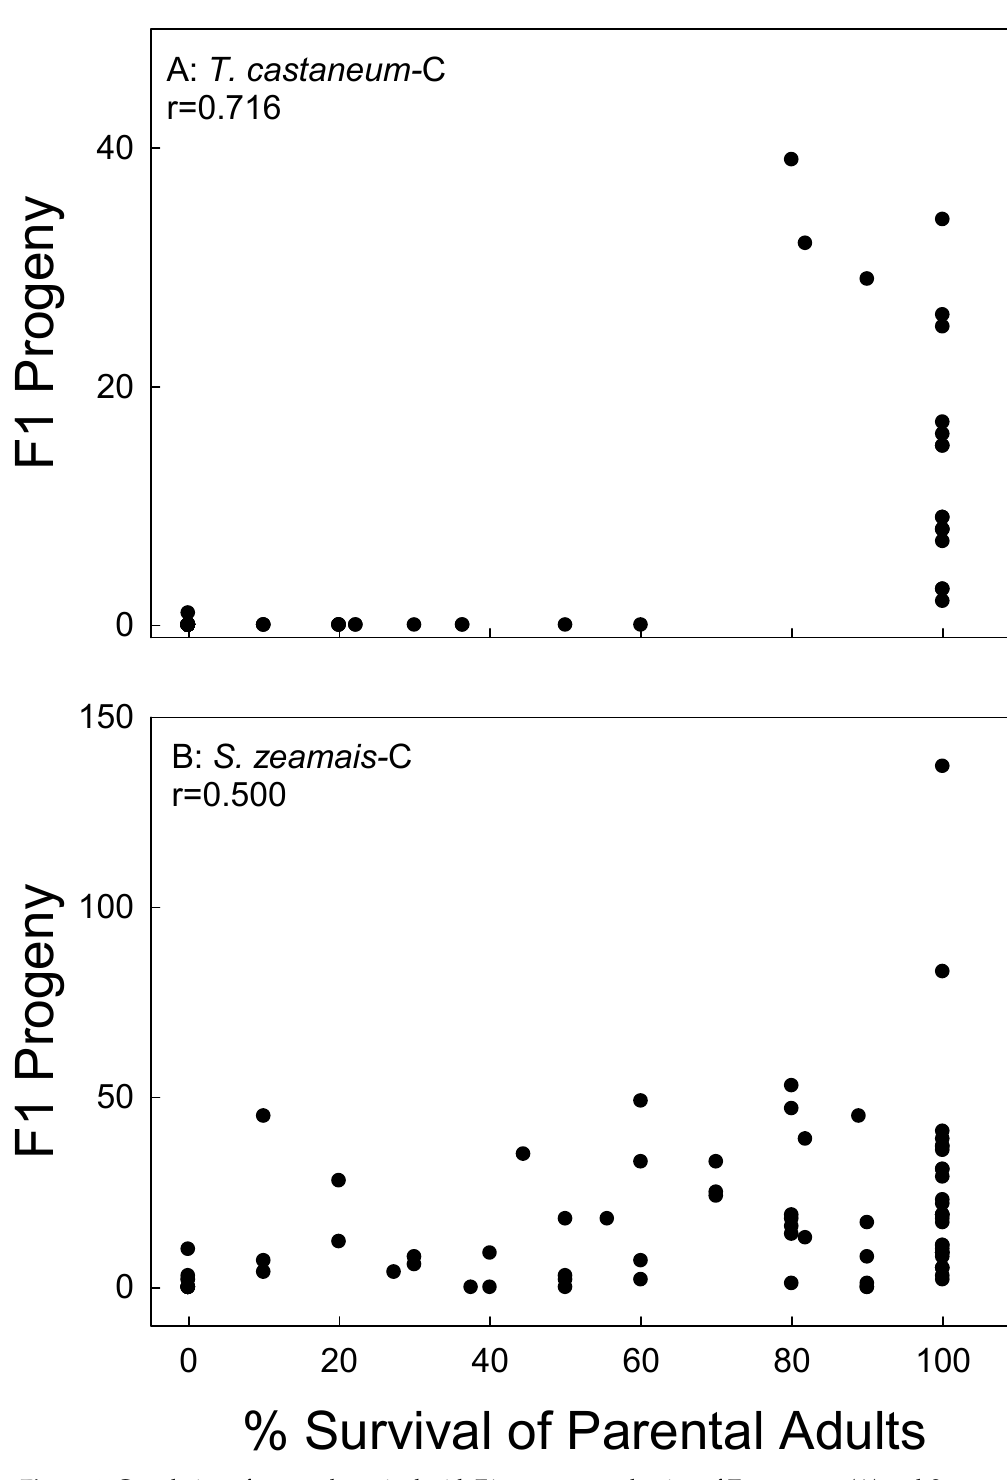
Figure 4. Correlation of parental survival with F1 progeny production of T. castaneum ( A ) and S. zeamais ( B ) on corn ( C ). Data combined for treatments and all bioassay months.